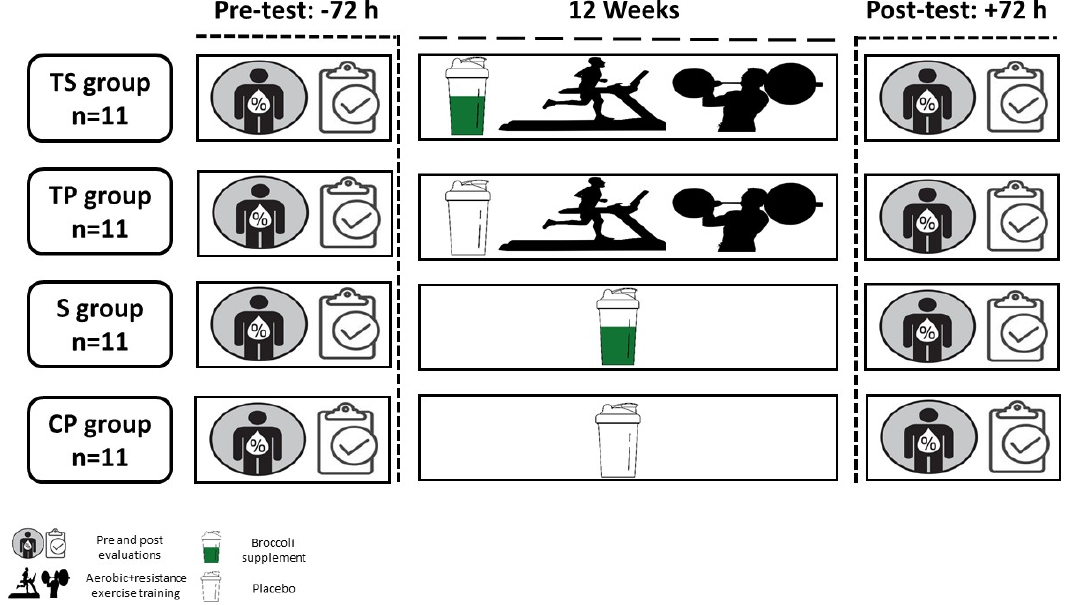
Figure 2. Experimental design. CP, Control–Placebo; S, Supplement; TP, Training–Placebo; TS, Training–Supplement.